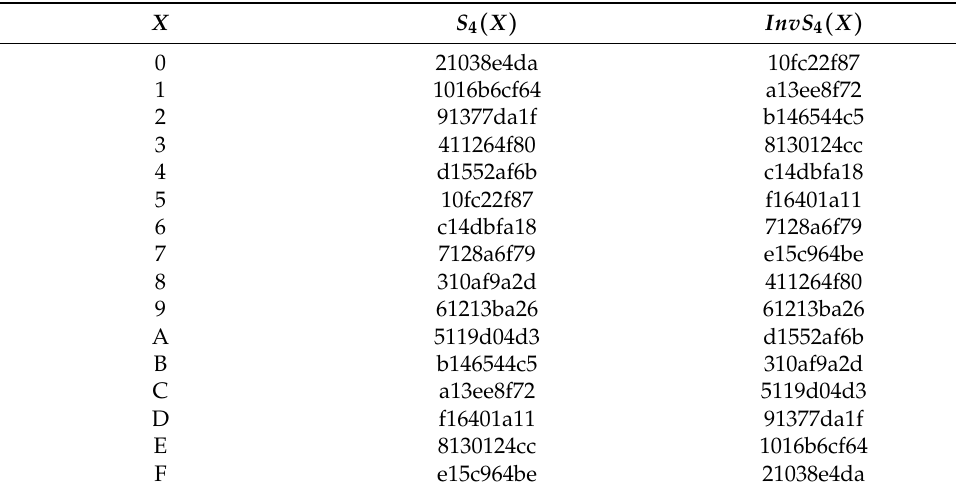
Table 14. New generated 32-bit output S-Box to replace Table 5.